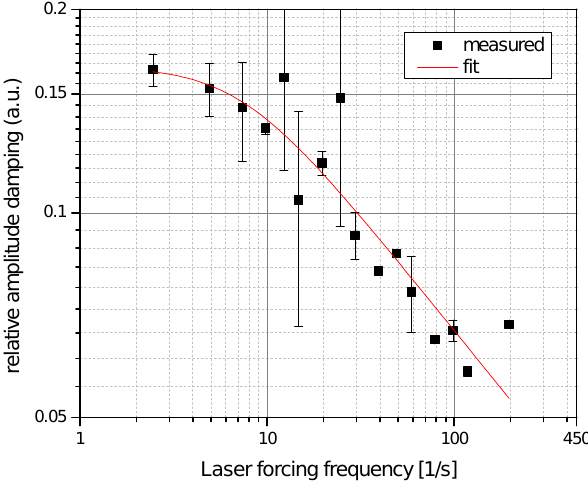
Figure 4. Example for measured amplitude damping plotted against that of the laser forcing frequency at a friction velocity of u ∗ = 2 . 46cms − 1 . At low forcing frequencies the thermal equilibrium was barely